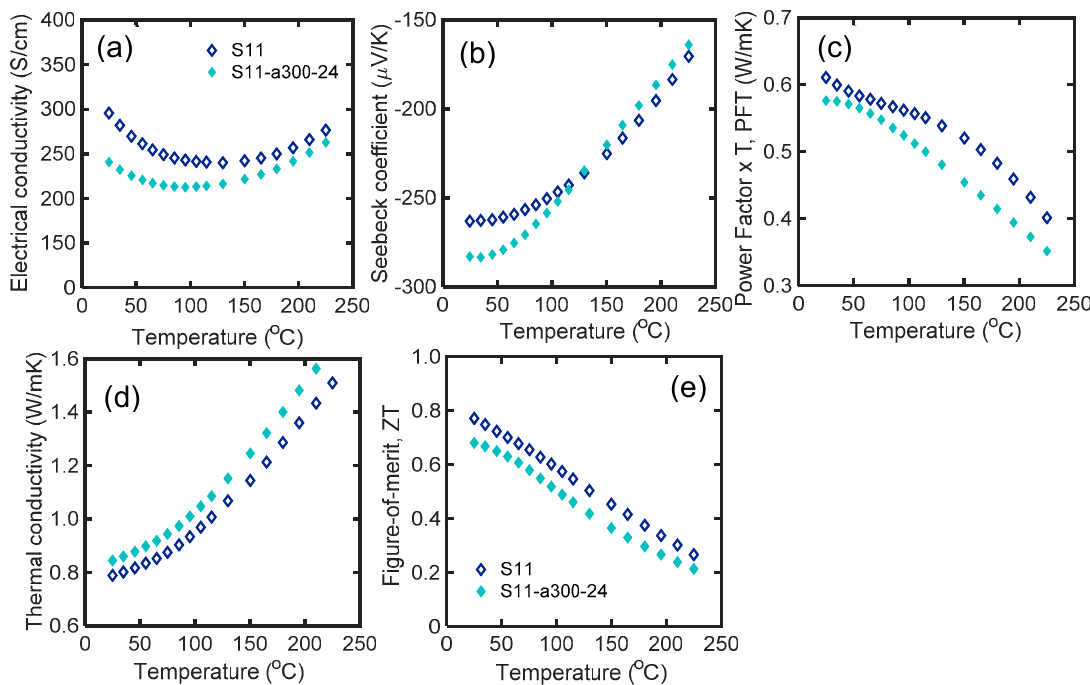
Figure 7. ( a ) Electrical conductivity; ( b ) Seebeck coefficient; ( c ) PFT; ( d ) thermal conductivity; and ( e ) zT of S14 and S14-a300-24 samples as a function of temperature in the range of 25 °C to 225 °C. According to Table 1, S14-a300-24 is S14 after annealing at 300 °C for 24 h.